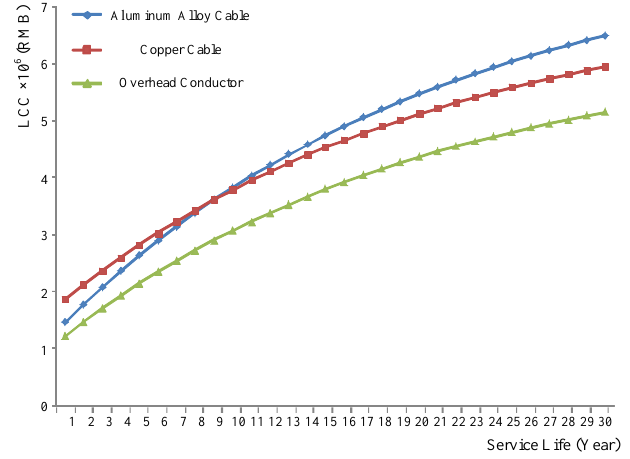
Figure 7. LCC during 30 years in Case 1.